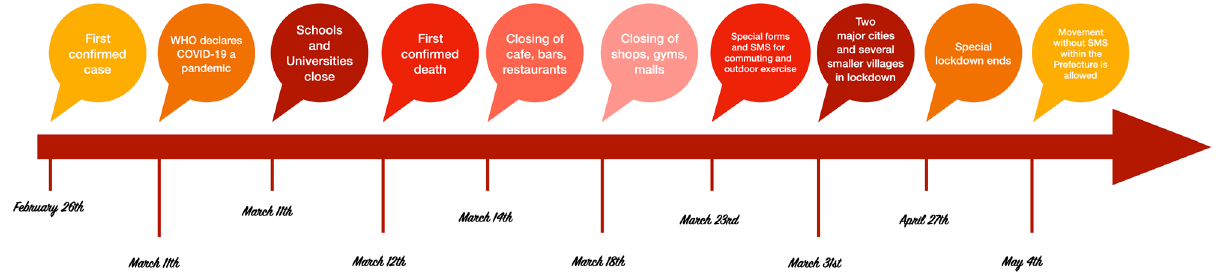
Figure 7. Timeline of COVID-19 in